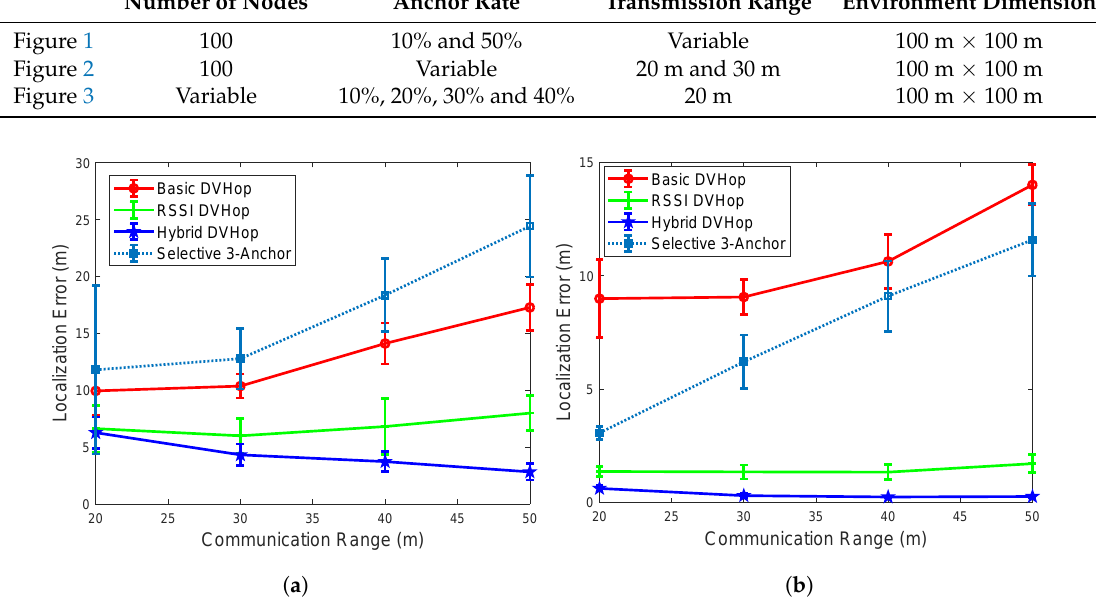
Figure 1. Localization error vs. transmission range. ( a ) Anchors Rate = 10%; ( b ) Anchors Rate = 50%.